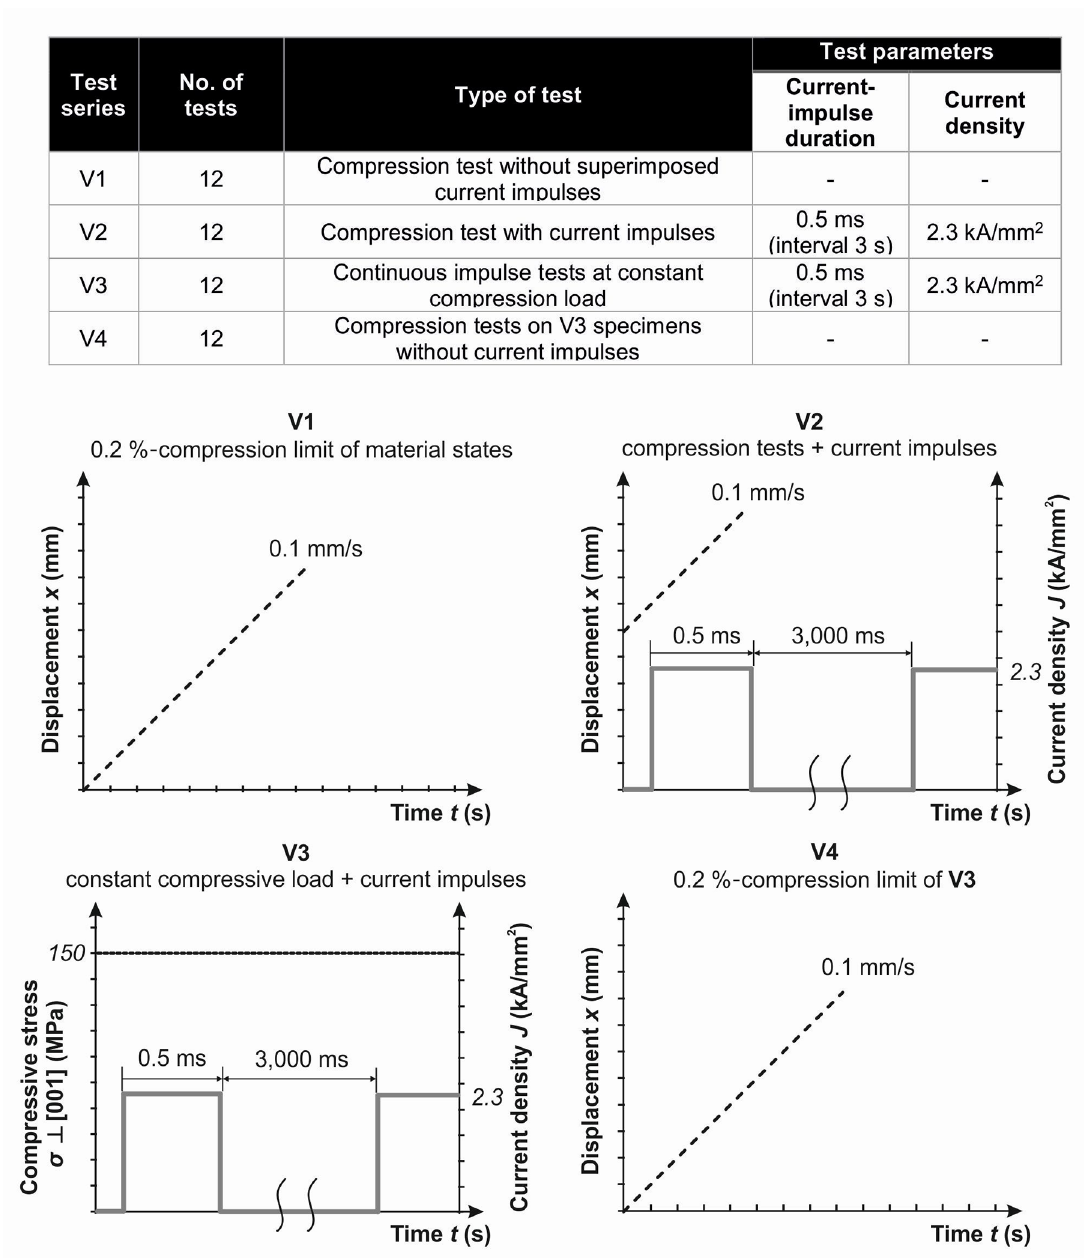
Figure 3. Table with test versions of the high-current impulse tests and schematic representation of the mechanical and electrical loading from test series V1, V2, V3 and Back-scattered electron (BSD) images of the measuring locations are depicted at which the elemental distribution was measured prior to and after the current-impulse treatment (cf. Fig. 1). For the line scans, one measuring location was chosen in the interdendritic region for each condition since the content of more rapidly diffusing elements is elevated in this region.